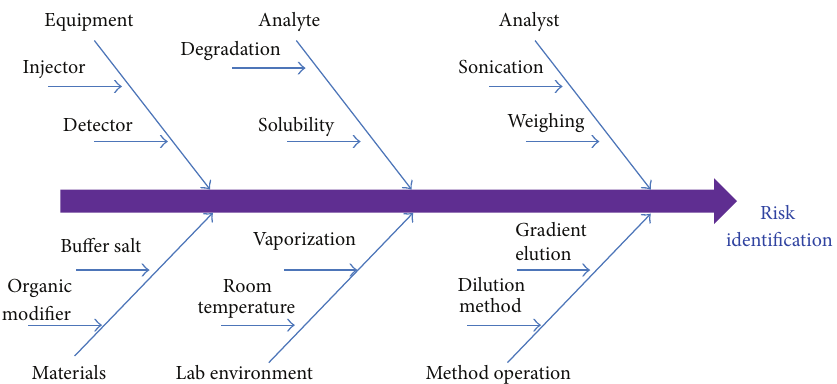
Figure 5: Fishbone for Risk identification.